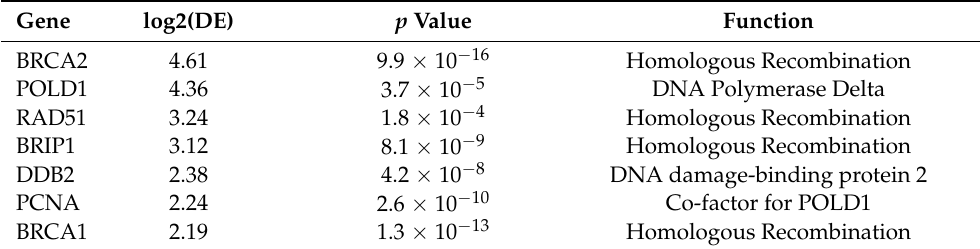
Figure 1. Differential Expression of Individual DNA Damage Repair Genes. A volcano plot of differentially expressed genes with the genes categorized by the NanoString software as being related to DNA damage repair highlighted in orange. The x-axis displays the fold change in DE laterally, while the y-axis displays decreasing p values vertically. The orange horizontal line depicts the p -value threshold of 0.01, and the orange vertical lines depict the 4-fold change threshold used to identify the most dysregulated DNA damage repair genes. Table 2. DNA repair genes with significant differential expression.